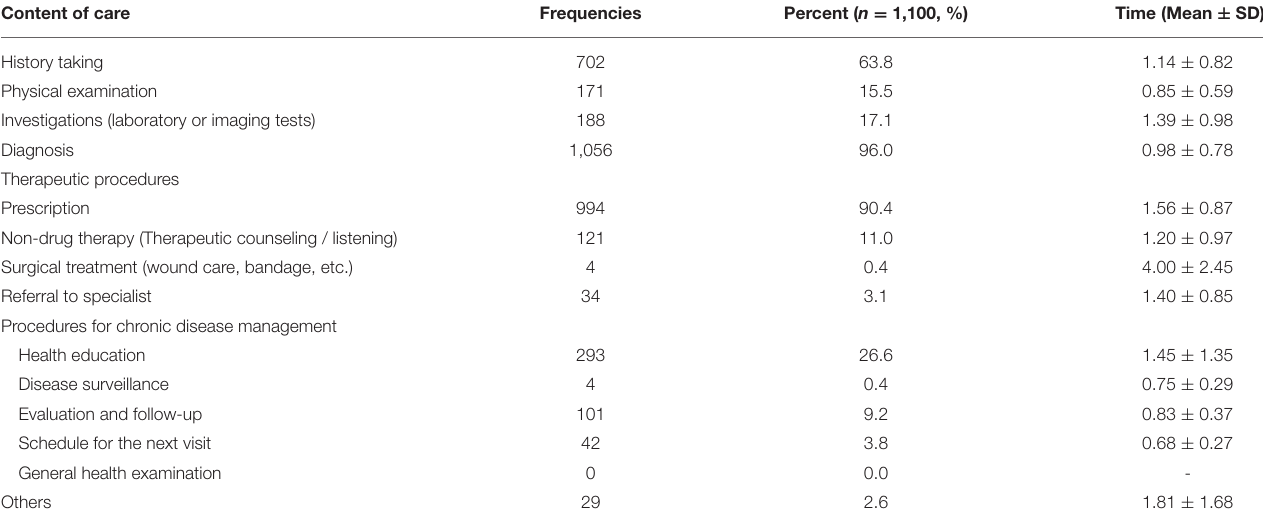
TABLE 3 | Content of GPs’ practice and time spent during the consultation. Content of